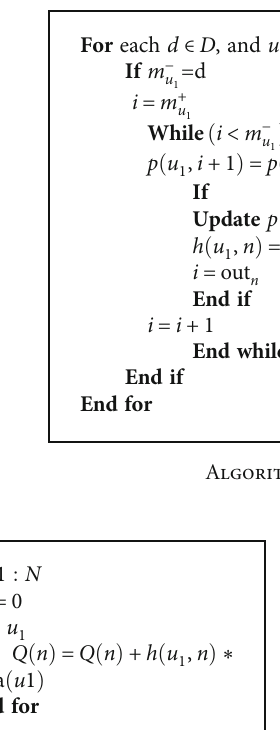
Algorithm 3: Calculate num ð n Þ